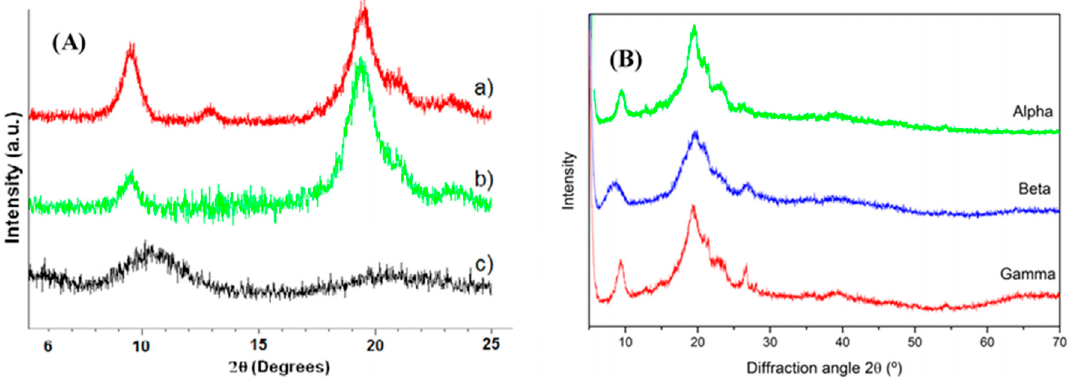
Figure 4. ( A ) XRD spectra of ( a ) chitin flakes, ( b ) chitin nanofibrils (CNF) and ( c ) a chitosan